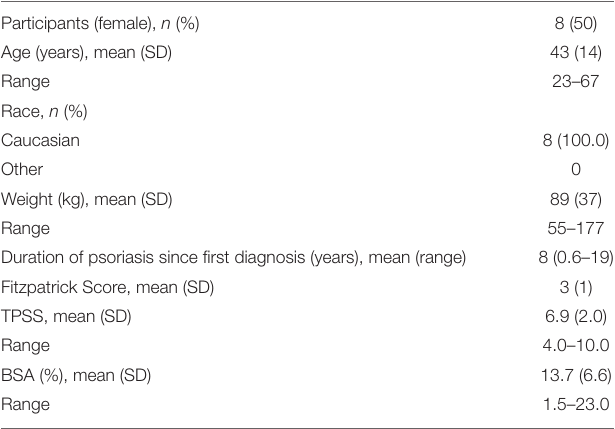
TABLE 1 | Patient characteristics at baseline. TABLE 2 | Adverse site